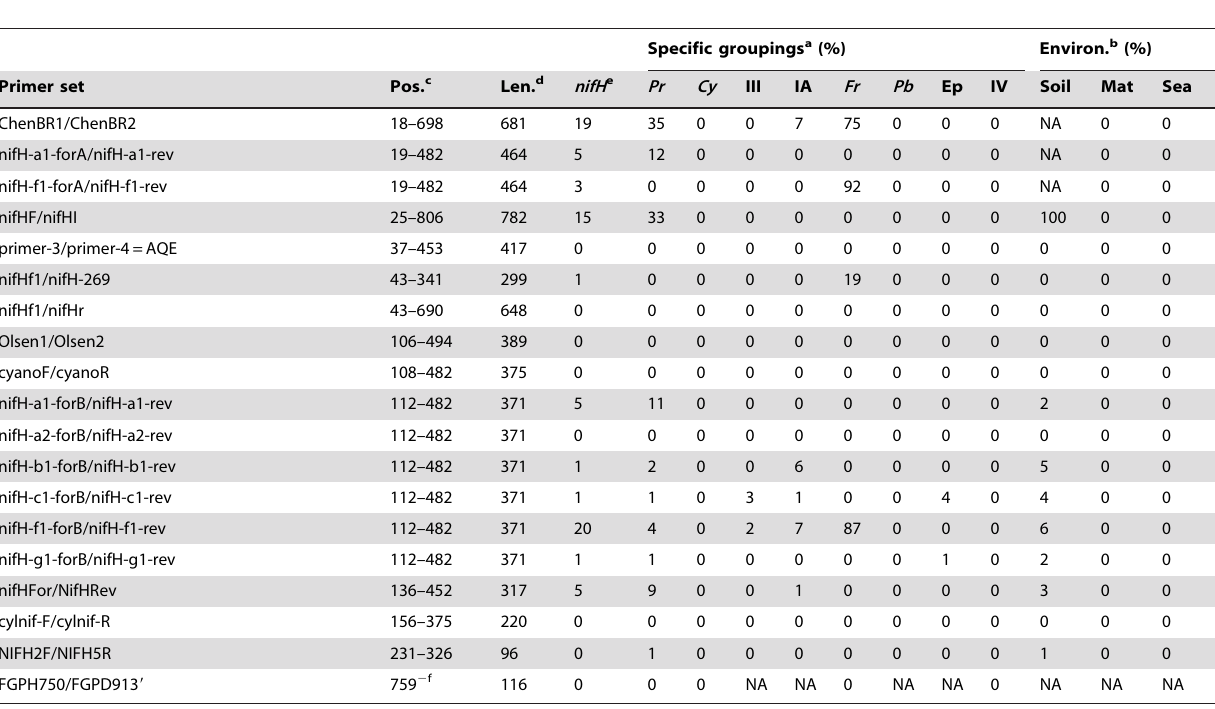
Specific groupings a (%) Environ. b (%)